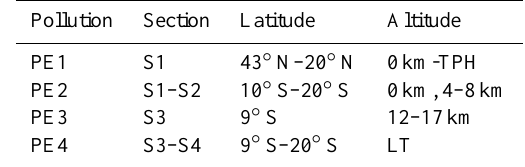
Table 2. CO pollution events (PE1–PE4) during the ship campaign with RV Sonne in the Western Pacific (TPH: tropopause height, LT: lower